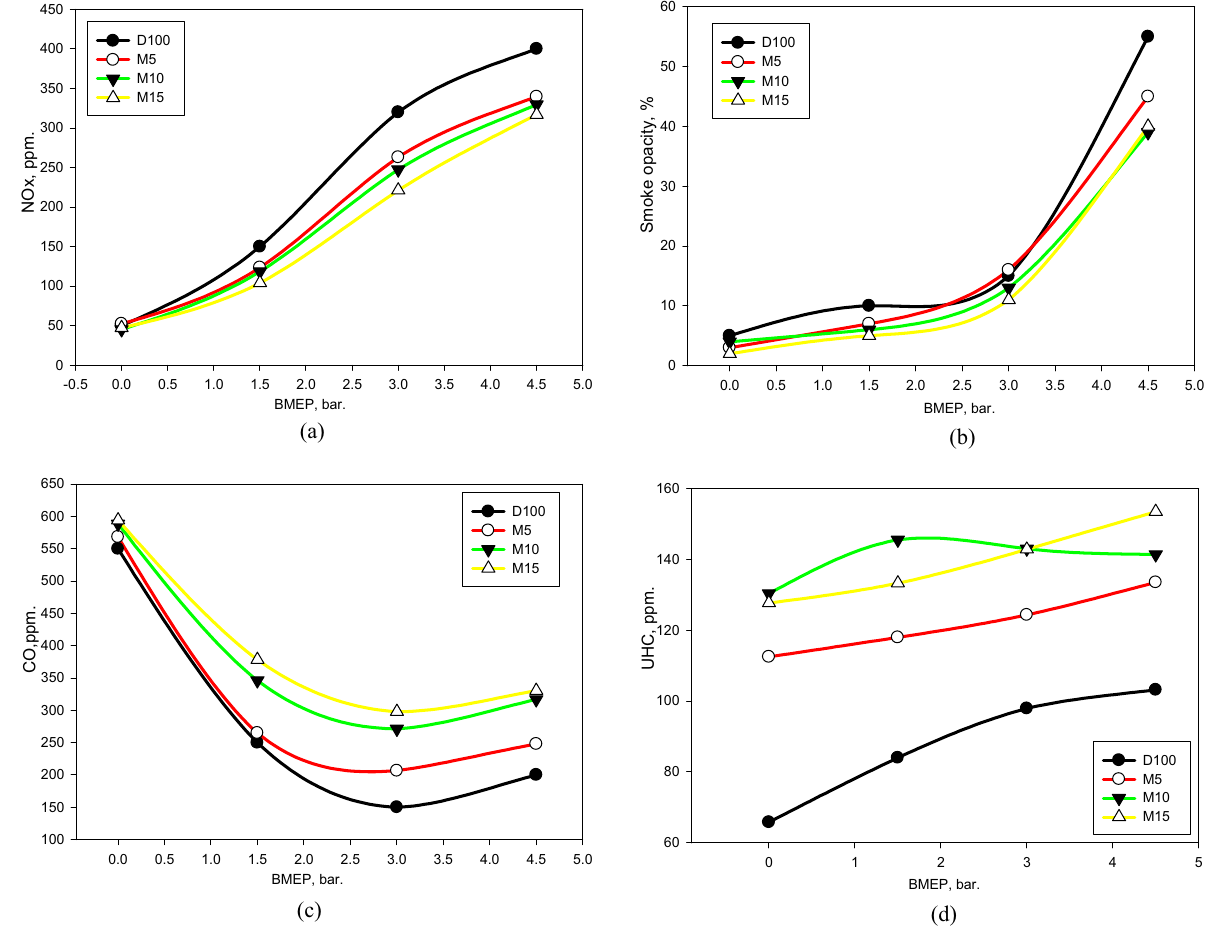
Figure 9. ( a ) NO x , ( b ) smoke opacity, ( c ) CO, and ( d ) UHC of assessed fuels at different